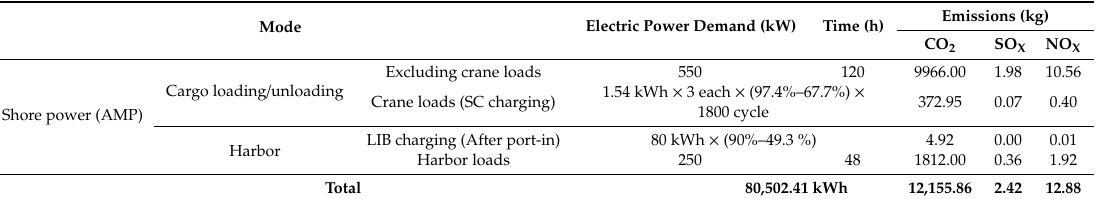
Table 15. Emissions from shore charging (proposed system).